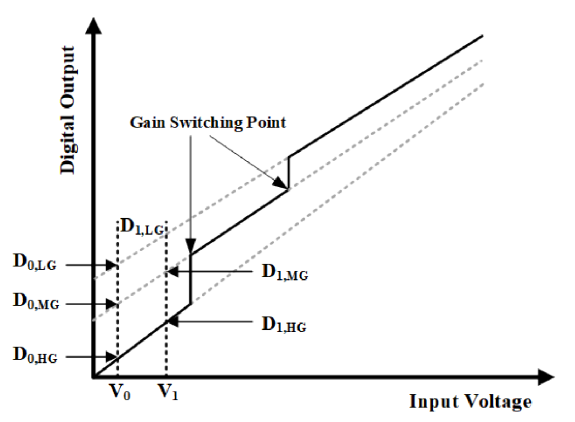
Figure 21. The quantization result with nonlinearities and calibration